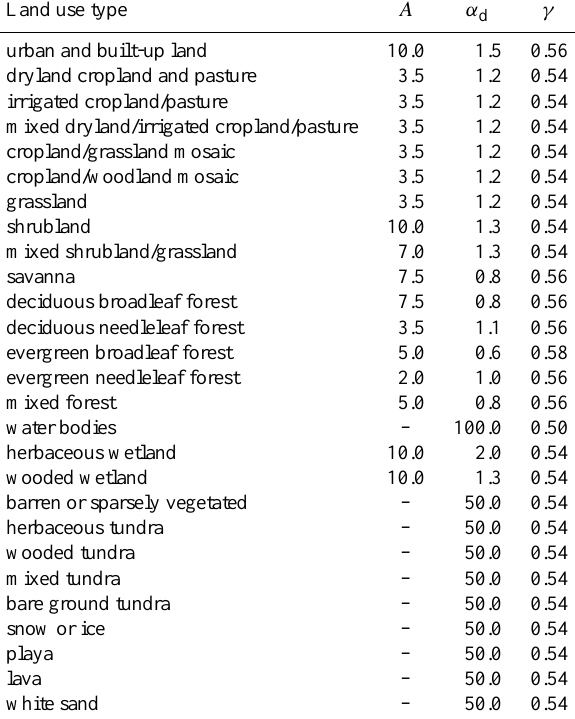
Table 2. Characteristic radius of collectors A and parameters α d and γ in the dry deposition scheme dependent on NMMB model land use type. Values were reassigned to 27 WRF-USGS land use types from the 15 land use types used in Zhang et al.